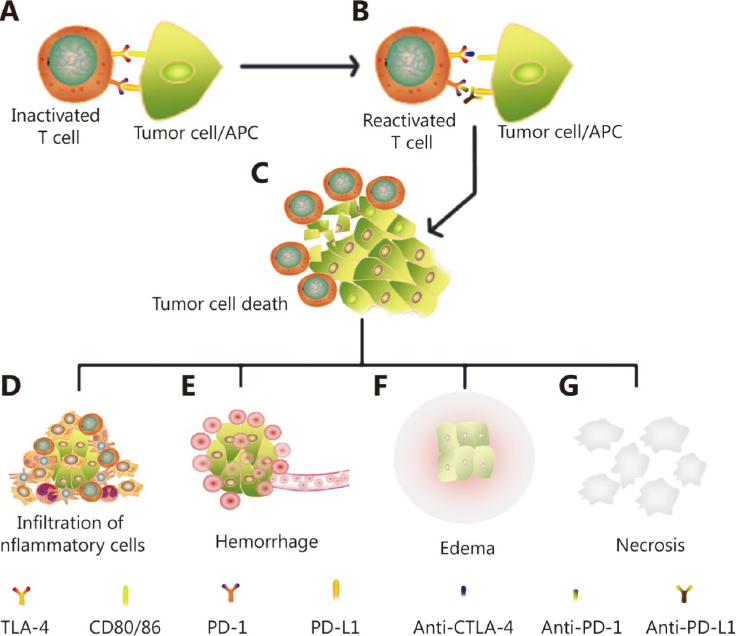
Figure 1. A mechanistic illustration of immunotherapy induced pseudo-progression, where the immune system response to treatment falsely appears in medical images as progressive cancer. Initially, inactivated T cells ( A ) are reactivated ( B ) subsequent to the administration of immune checkpoint inhibitors. This yields tumor cell death ( C ) and releases antigens which attract additional infiltrating inflammatory cells ( D ). The tumor shrinkage then causes vascular tears and hemorrhage ( E ), which is expressed as lesion edema ( F ). The combination of necrotic tumor cells ( G ), inflammation ( D ), hemorrhage ( E ), and edema ( F ) is ultimately (and falsely) expressed as tumor progression when examined using conventional clinical MRI. Reproduced from [64]. Copyright ©2019, Cancer Biology & Medicine (CC BY 4.0